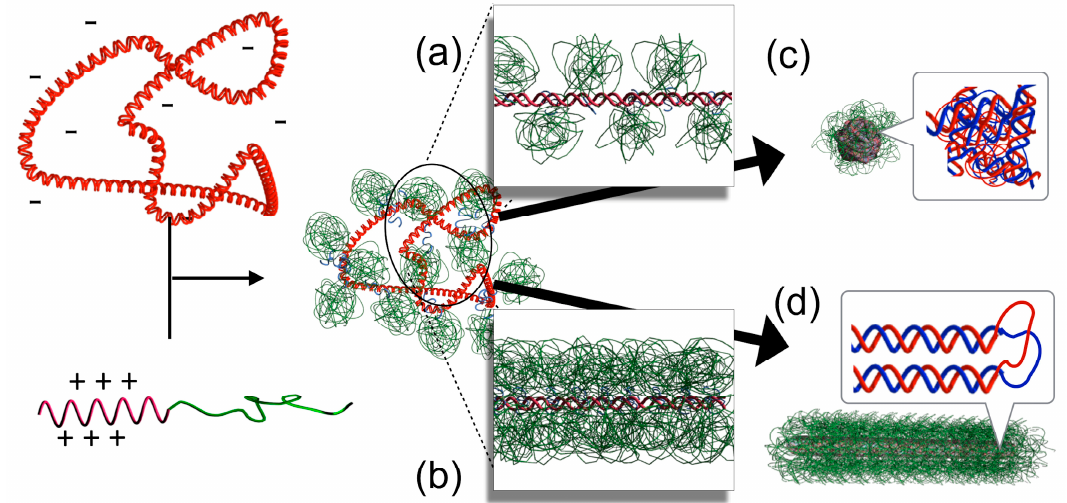
Figure 4. Schematic illustration of the critical role of PEG crowding in the process of pDNA condensation by block copolymers ( a , b ) and the integrity of double-stranded DNA in the condensates ( c , d ).